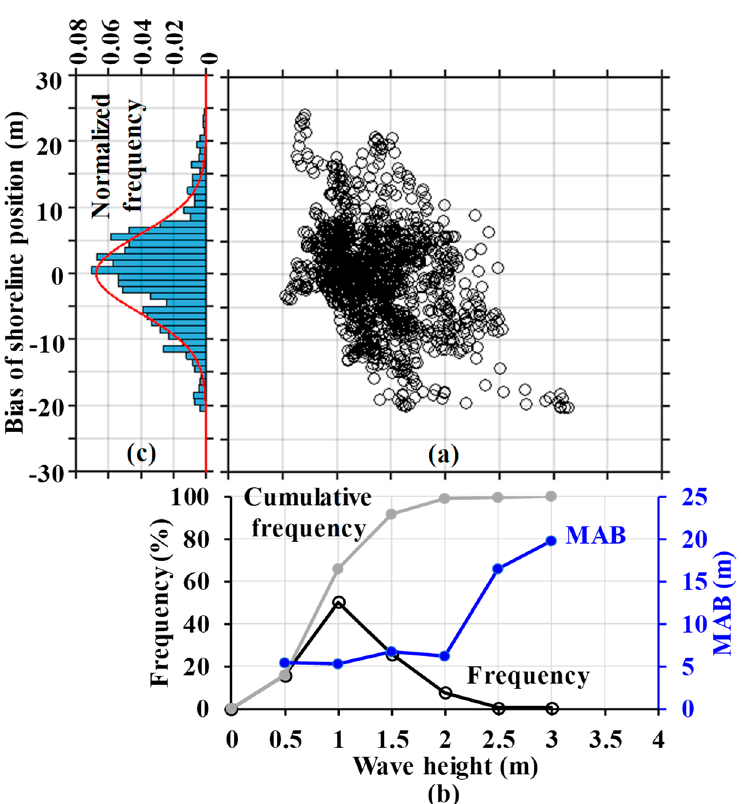
Figure 27. ( a ) The relationship between the wave height and estimated bias of the shoreline positions. ( b ) The frequency distribution of the wave height and corresponding MAB estimations of the shoreline positions. ( c ) The frequency distribution of the estimated bias of shoreline positions.